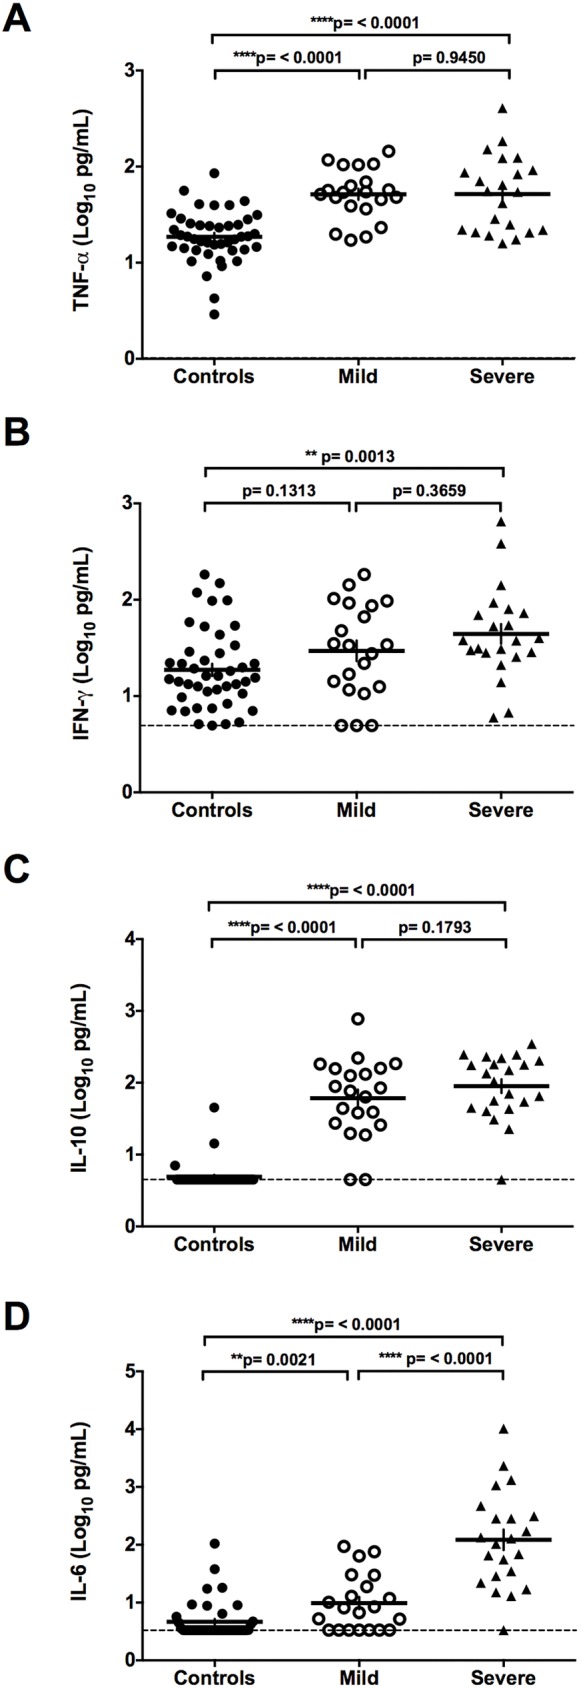
TNF-α, IFN-γ, IL-10, and IL-6 levels in control and ANDV-infected patients.Circulating levels of cytokines (A) TNF-α, (B) IFN-γ, (C) IL-10, and (D) IL-6 in serum samples of Control individuals and ANDV-infected patients with Mild or Severe disease progression are represented by dots. Each value expressed in pg/mL was transformed to Log10 (pg/mL) to facilitate comparison between the groups. A Mann-Whitney test for continuous variables was performed to evaluate significant differences between Controls and Mild or Severe, and Severe versus Mild groups. The dashed line represents the lower limit of detection. The ends of the brackets indicate the compared groups. Each serum sample was analyzed in duplicate in the same plate.